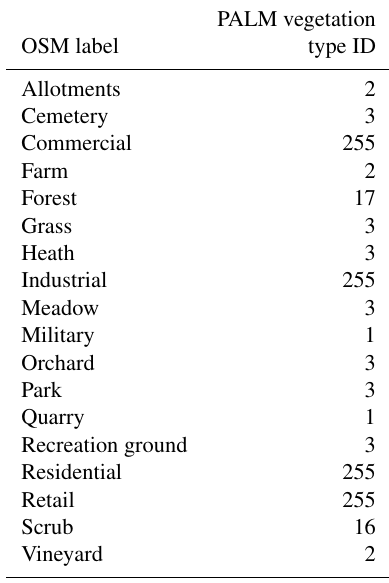
Table B2. OSM land use classes to PALM vegetation type. “255” is a fill value, assigned to non-vegetation pixels. PALM